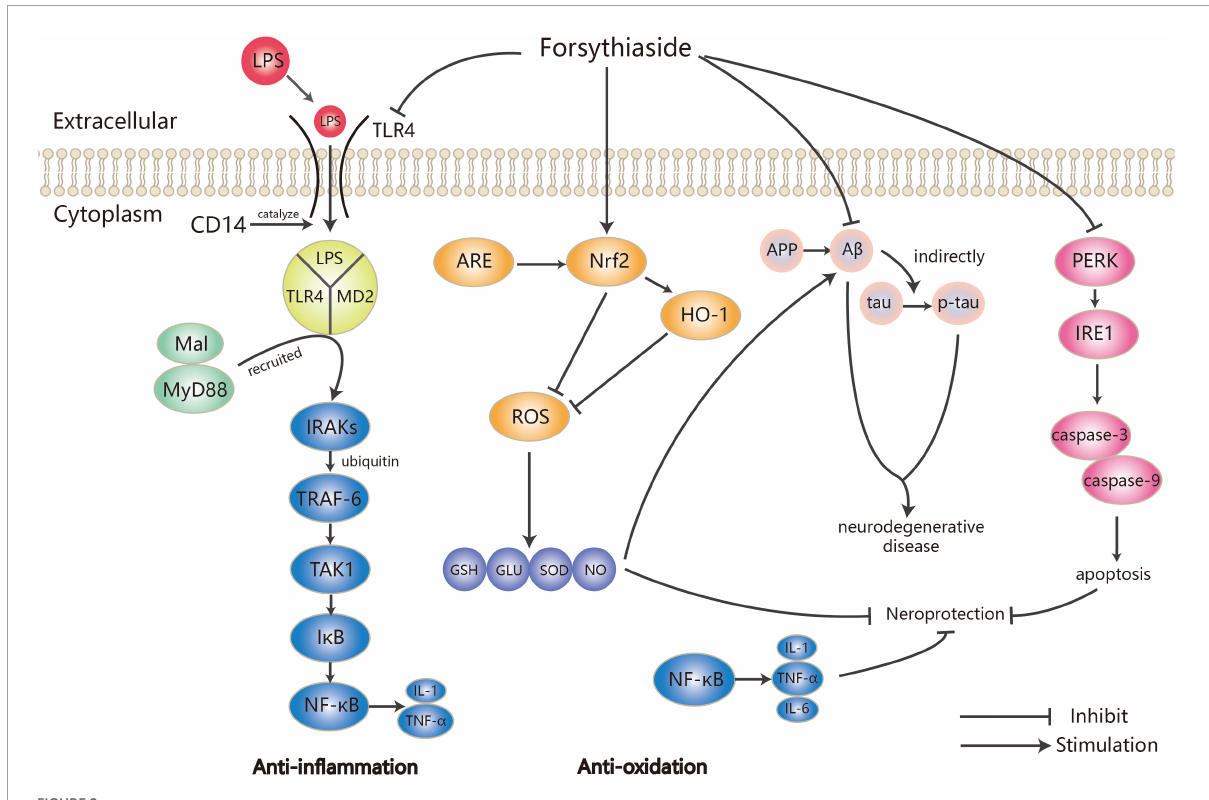
FIGURE2 Mechanism of anti-inflammation and anti-oxidation by